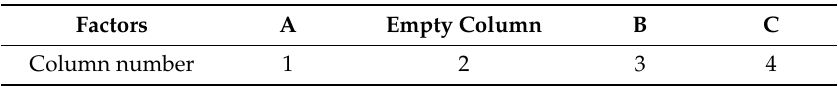
Table 2. The table header design of the orthogonal experiment for the structural parameters of the straight cone